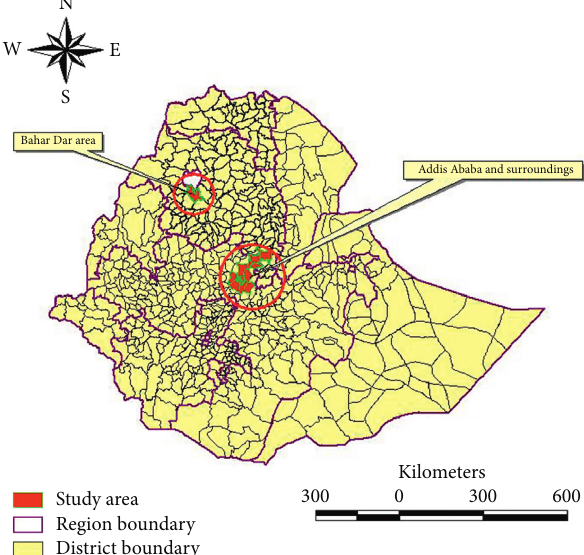
Figure 1: Map of study